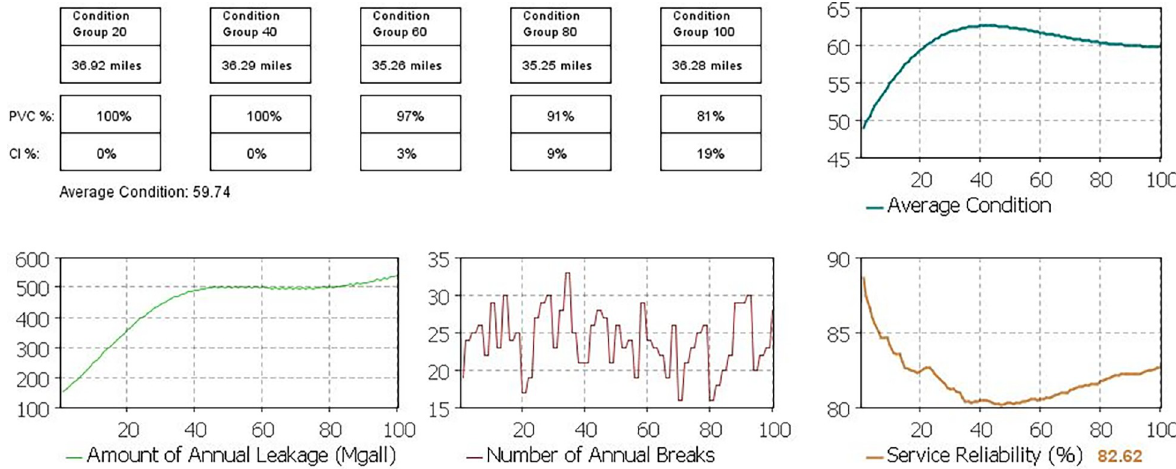
Fig 7. Simulation model output dashboard: Visualized long-term performance regimes.